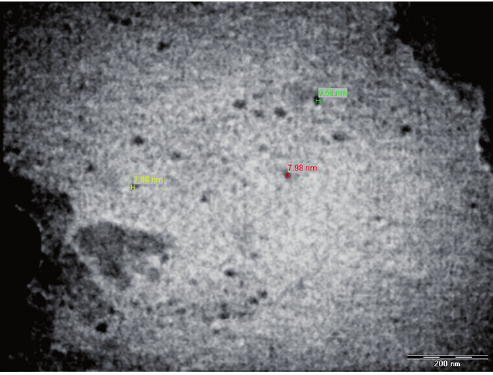
70b a F 3: TEM image of Pd/SPC composite materials. F 4: SEM image of Pd/SPC composite